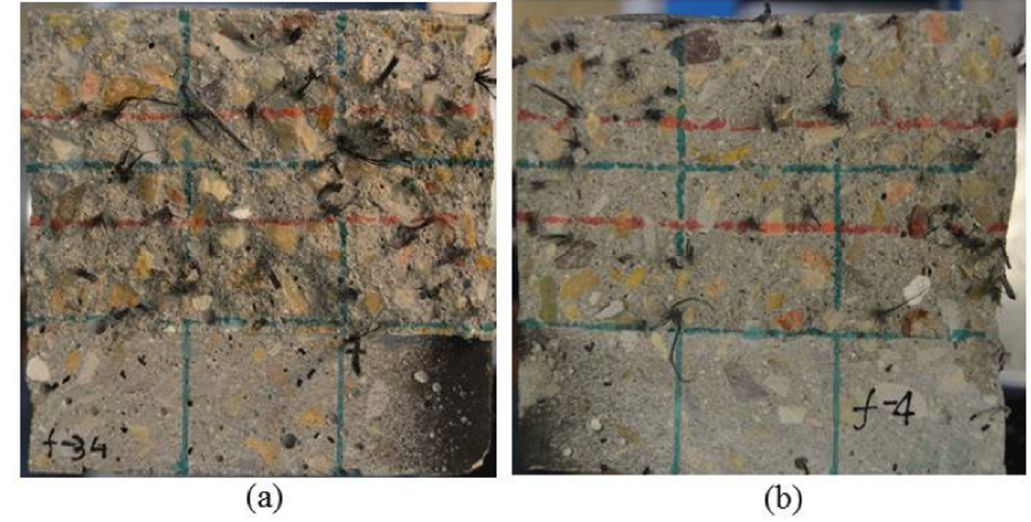
Figure 7. Fracture surfaces generated: ( a ) VCC6-60; ( b ) SCC6-60.